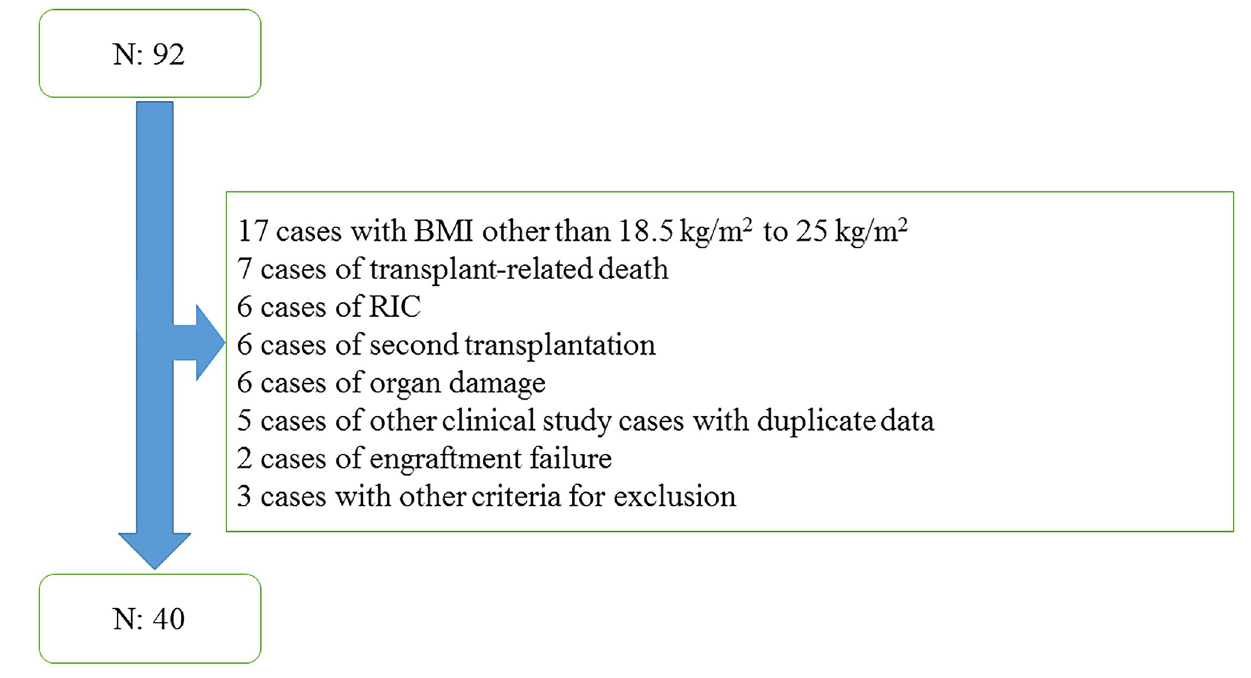
Fig 2. Flowchart of the patient selection and enrollment process.